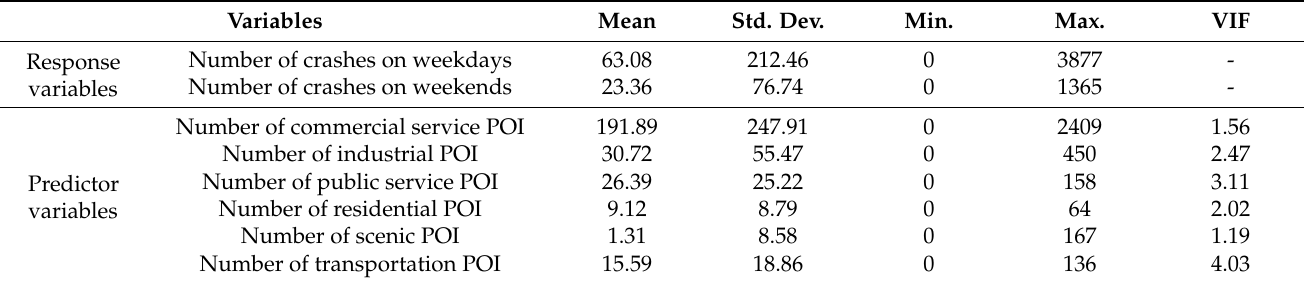
Table 2. Descriptive statistics of response and predictor variables based on